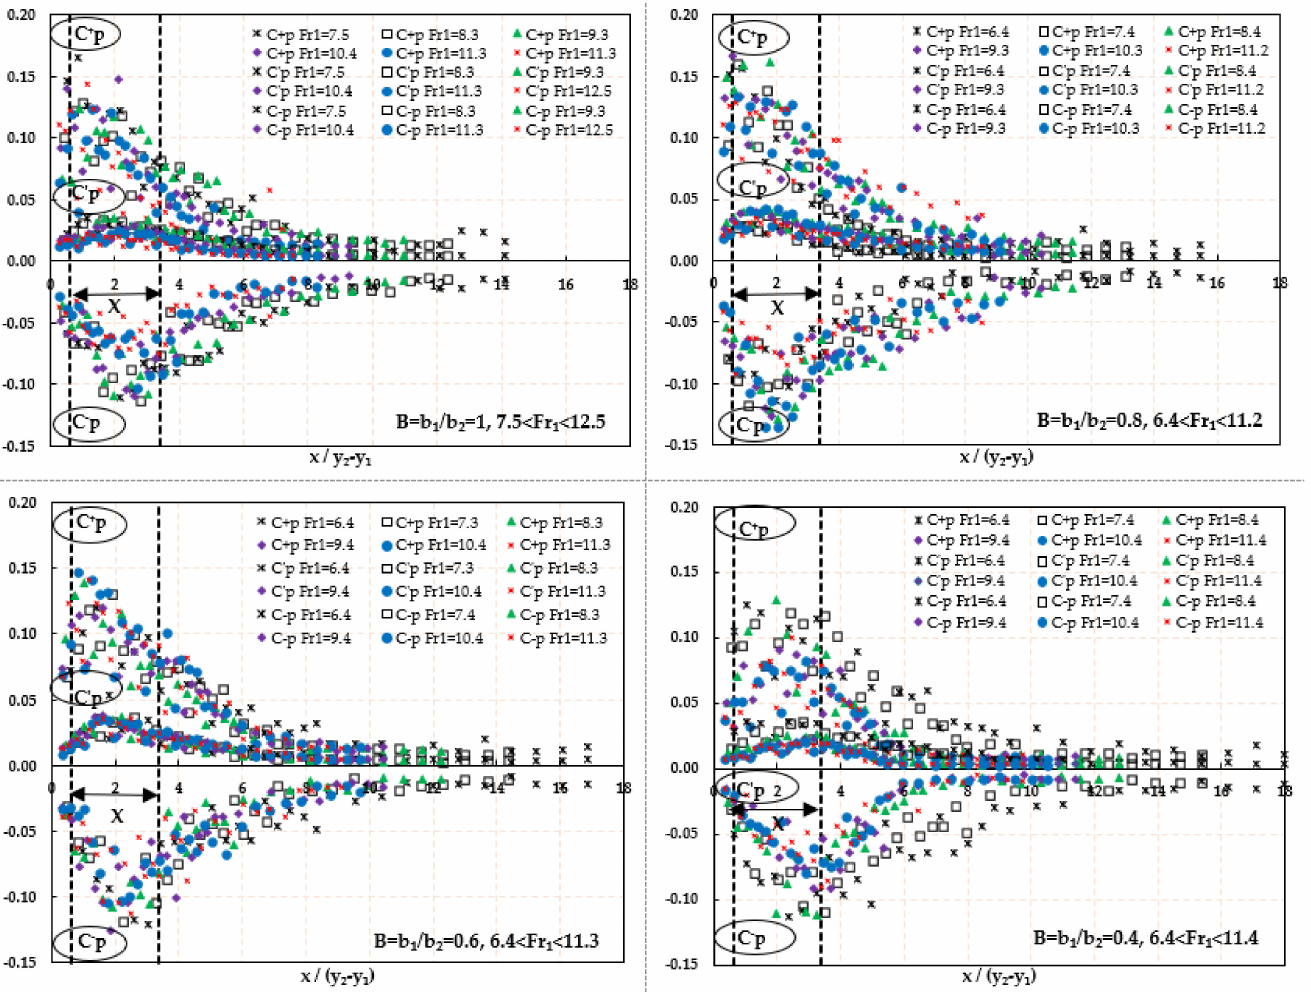
Figure 5. Positive and negative pressure fluctuation versus position in the hydraulic jump for different expansion ratios and different range of the Froude